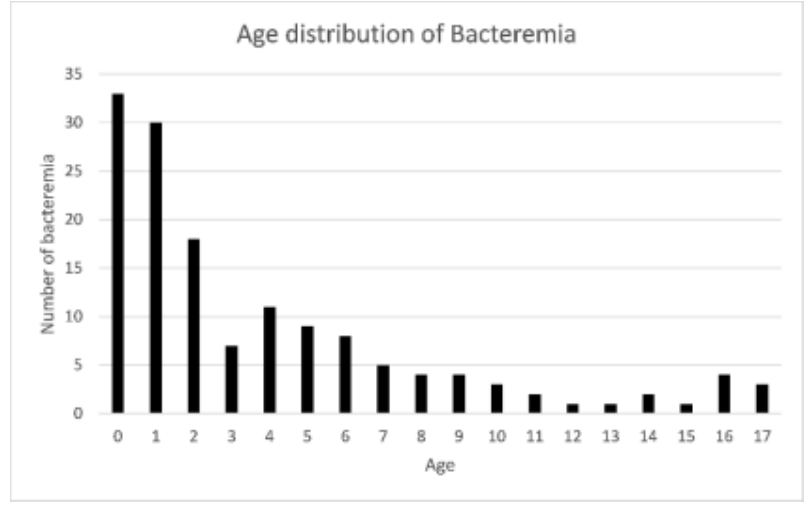
Figure 1. The distribution of bacteremia at different ages of the study population.